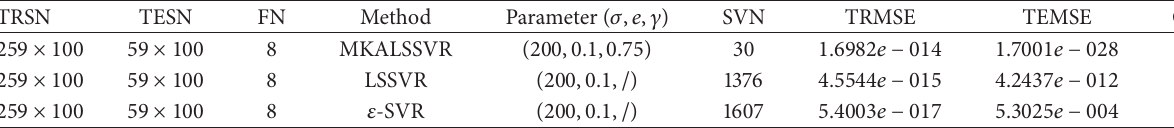
Table 1: Result of data feature and comparative experiment of regression problem on experiment data.